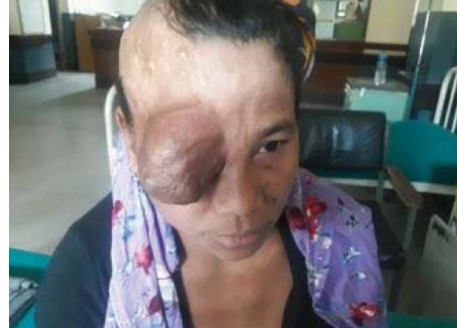
Figure 1. Preoperative picture showing the giant high-